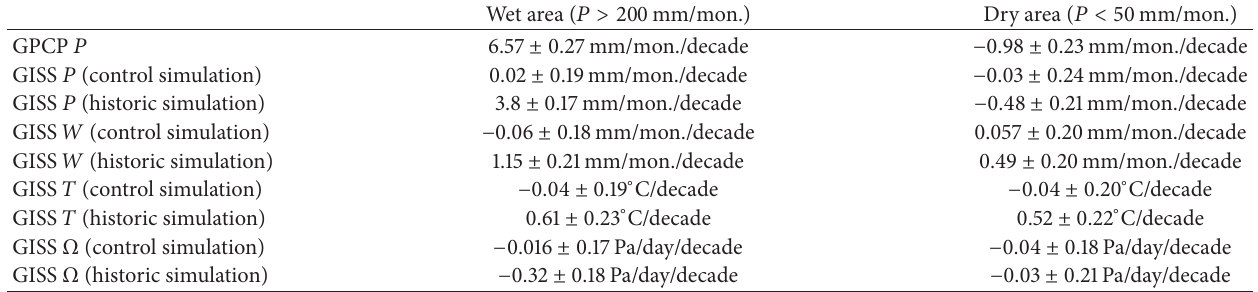
Table1:Trendsforprecipitation( 𝑃 ),columnwater( 𝑊 ),temperature( 𝑇 ),andverticalpressurevelocity( Ω )overwetarea( 𝑃 > 200 mm/mon.) and dry area ( 𝑃 < 50